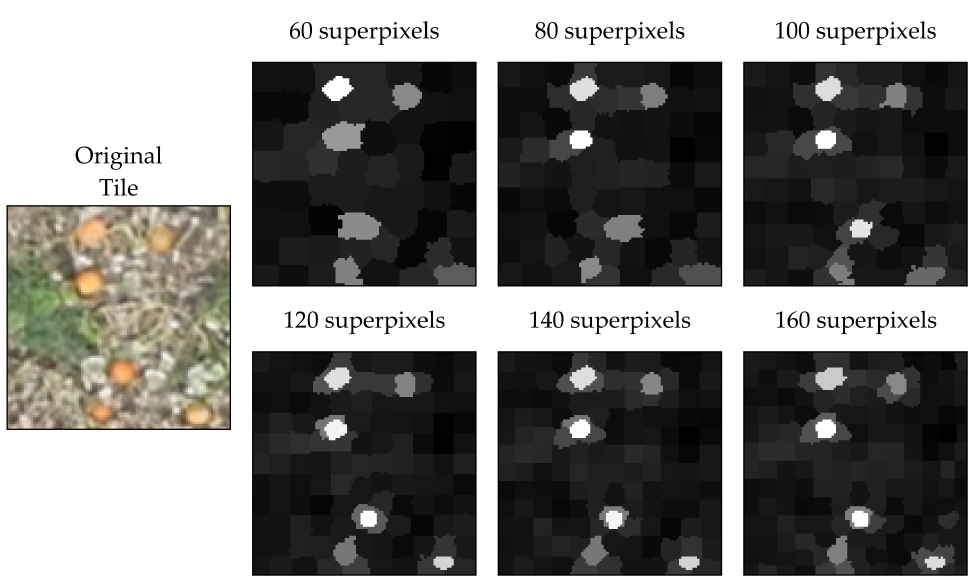
Figure 5. Results of segmentation with different threshold sizes for the number of superpixels. The conciseness parameter depends on the desired shape as well as the number of bands considered in segmentation. The values range between 0 and 100, however, for one band, the values are typically set within the lower side of this spectrum. The values of 0.1, 0.3, 0.5, 0.7, and 0.9 were tested (Figure 6). Following analysis of the results, a threshold of 0.3 was chosen as the optimal solution for detail in color and roundness of the superpixels.